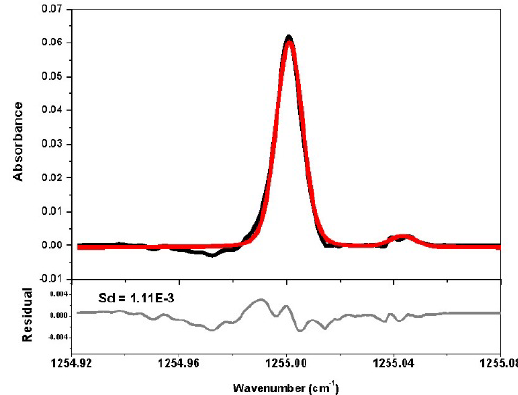
Figure 6. Upper panel : Absorption spectrum of CH 4 (black curve) in ambient air (750 averaged spectra over 218 s) and Voigt profile fitting (red) to the experimental absorption line. Lower panel : Fit residual.